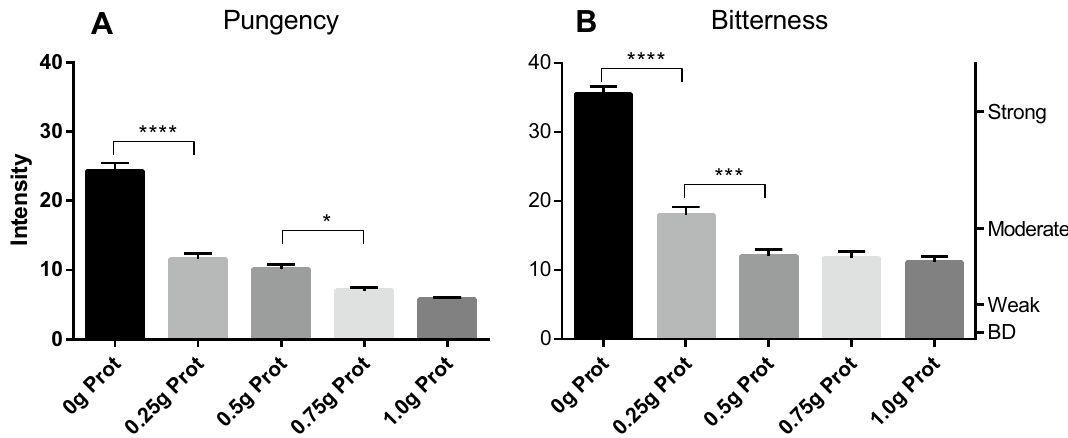
Figure 5. Perceived throat pungency ( A ) and bitterness ( B ) from mixtures made with HOC (EVOO high in OC), surfactants and increasing amount of whey proteins (0, 0.25, 0.5, 0.75 and 1 g/100 g oil). The right axis displays the corresponding portion of the LMS scale used by participants to provide their ratings (BD = barely detectable). 10 subjects (4 females and 6 males; average age 36) rated each sample 4 times in random order. Data are represented as mean + /- SEM. Statistics: ns = not significant; * p < 0.05; ** p < 0.005; *** p < 0.001; **** p <